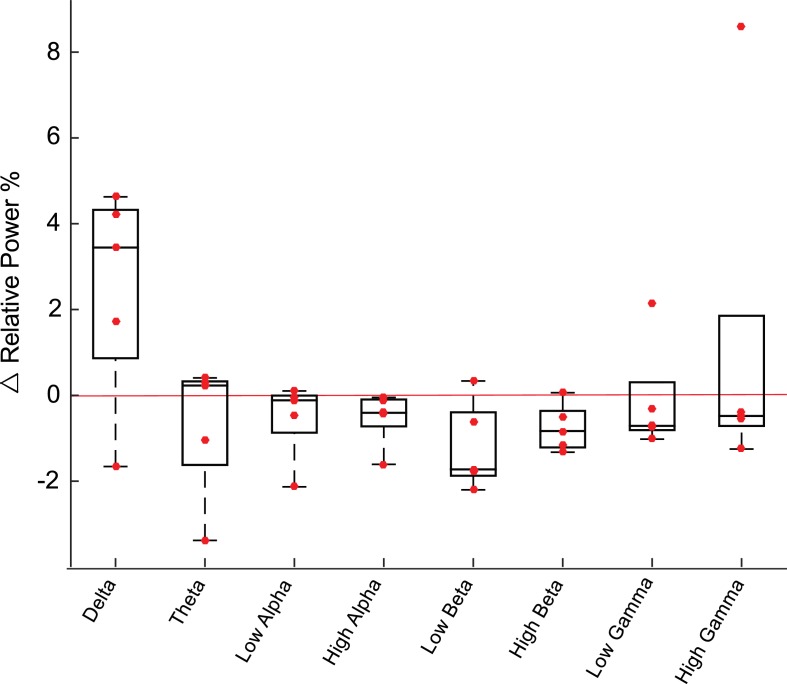
Control group EEG data.Data shown are relative power values in the UP-DOWN states, extracted for each participant’s hotspot electrode. Values greater than 0 indicate larger amplitude oscillations in the UP condition, and lower than 0 indicate larger oscillations in the DOWN condition. EEG recordings were only made in a subset of 5 participants, so individual datapoints are overlaid as red dots.